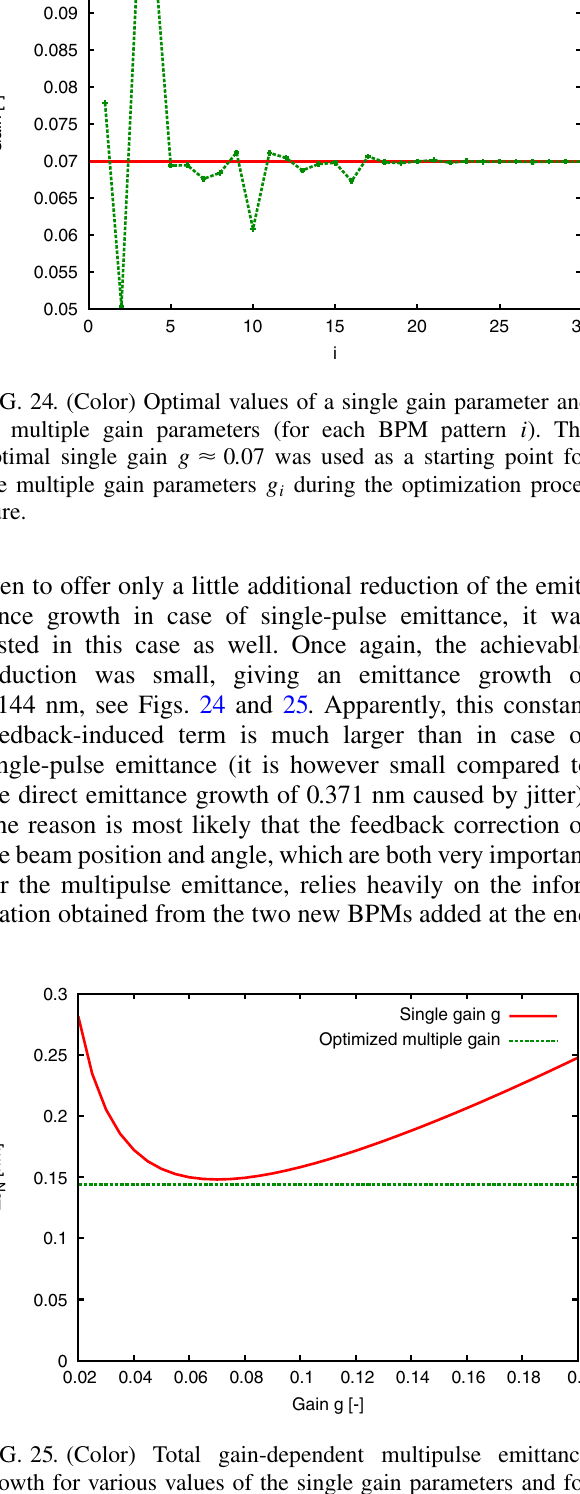
FIG. 23. (Color) Theoretical standard deviation of BPM read- ings for a large number of seeds. The maximum deviation for the optimized feedback is seen to be (cid:6) 0 : 7 nm , just as for the feedback system optimized for single-pulse emittance.